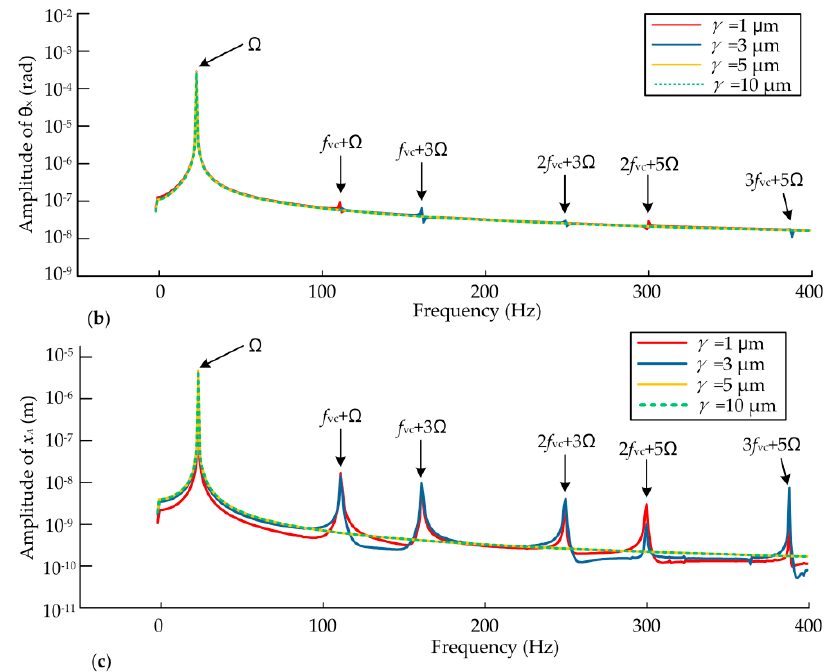
Figure 14. The spectra of dynamic responses for different rotor offsets. ( a ) The spectra of x ; ( b ) The spectra of θ x ; ( c ) The spectra of x A . Cont